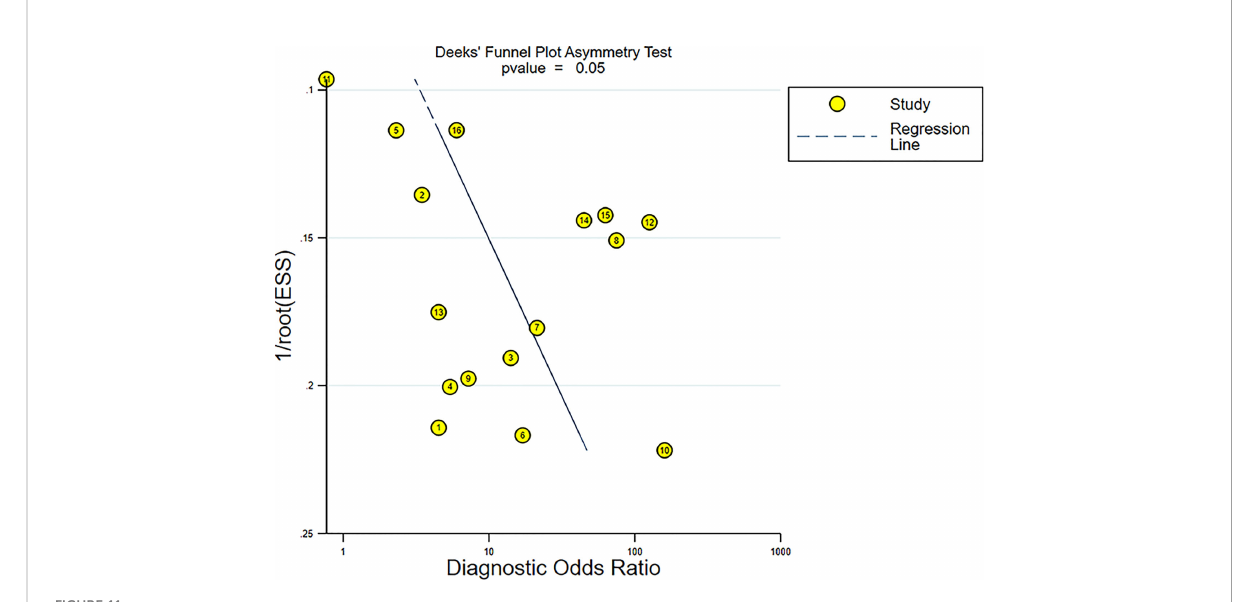
FIGURE 11 Funnel plot for evaluating potential publication